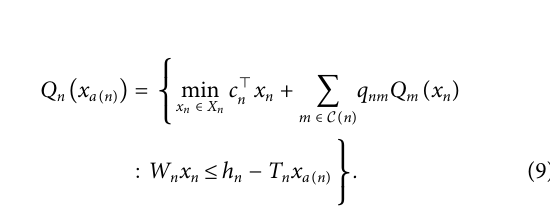
Frontiers in Chemical Engineering |